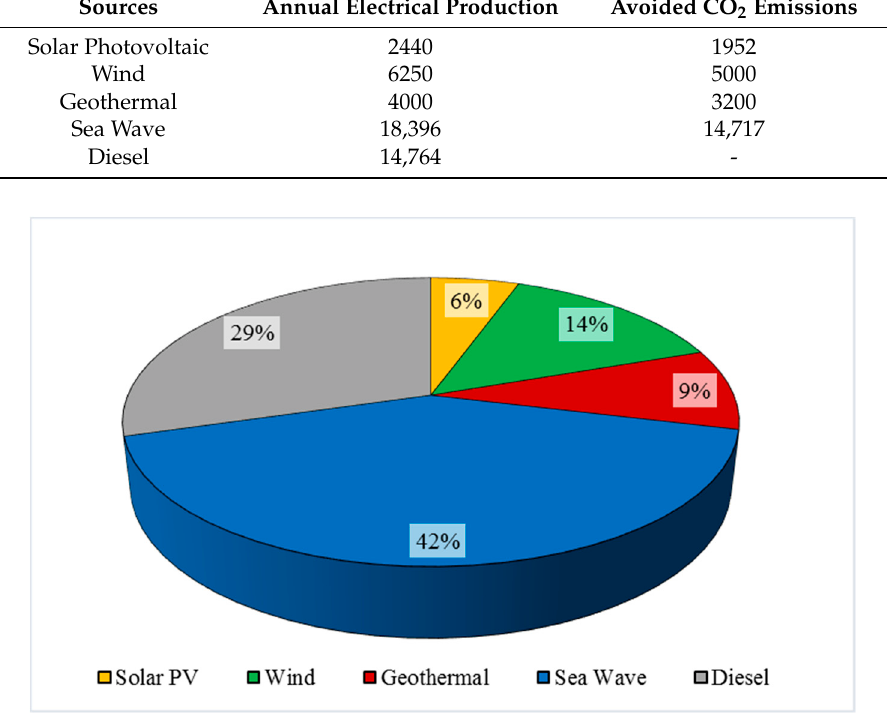
Figure 15. Energetic scenario by sources.